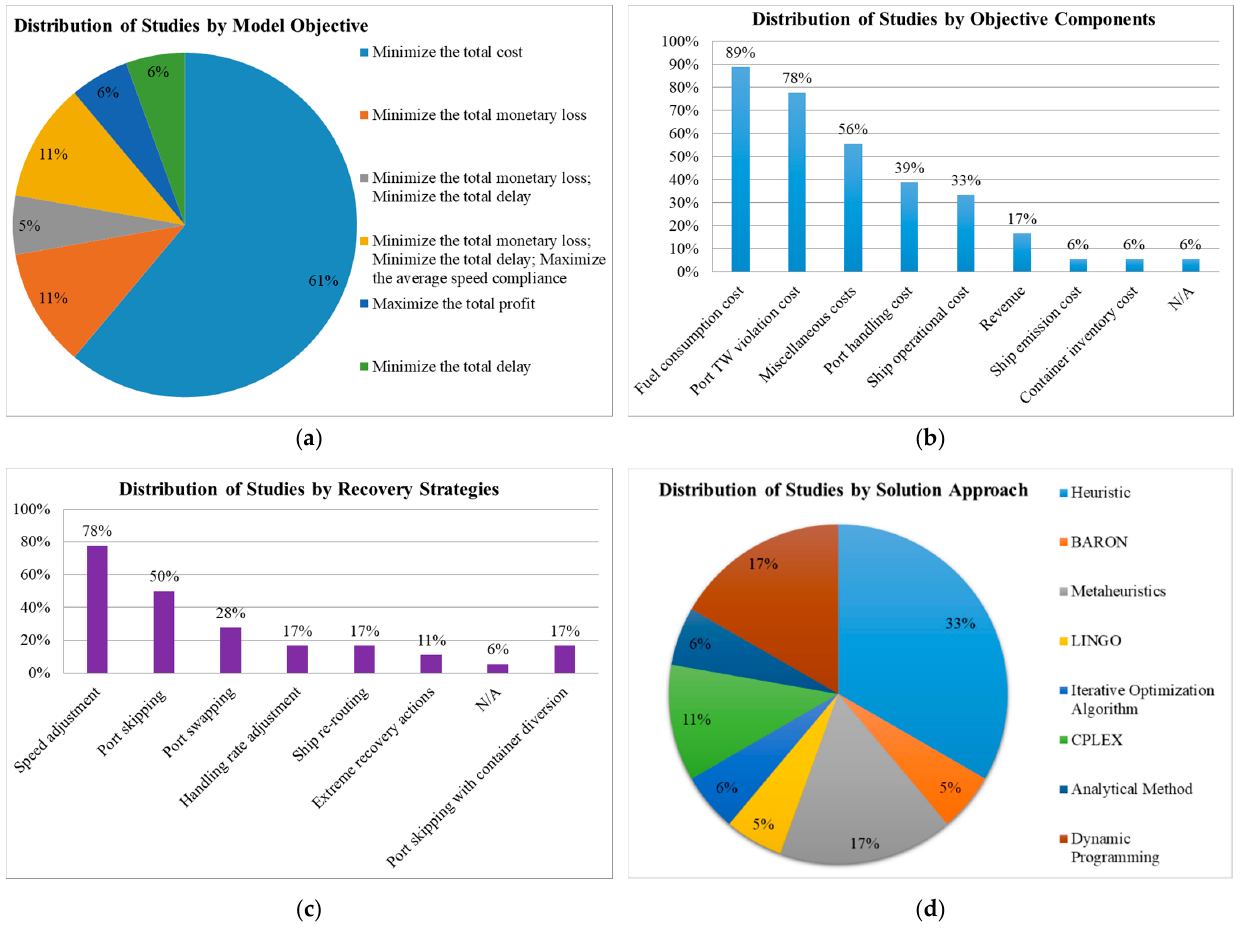
Figure 8. Distribution of the reviewed studies on ship schedule recovery by various attributes: ( a ) model objective; ( b ) objective components; ( c ) recovery strategies; and ( d ) solution approach.